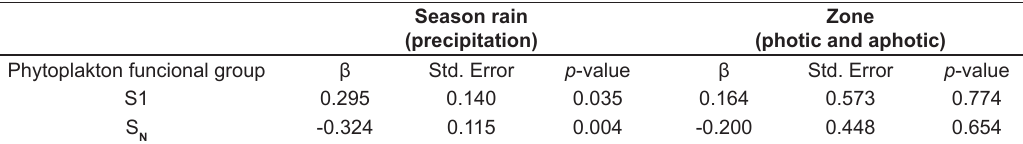
Table 5. Results of Model Logistics Regression (GLM) to identify variations between zones (aphotic and photic) and precipitation (season rain) in the presence and absence of functional groups. Only significant values are shown. Season rain Zone (precipitation) (photic and aphotic) Phytoplakton funcional group β Std. Error